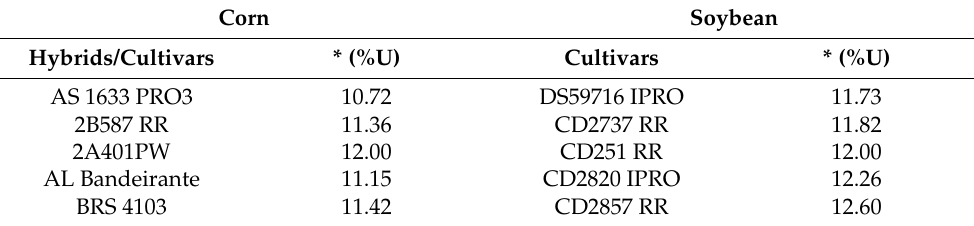
Table 1. Average water content for corn and soybean hybrids and/or cultivars. Corn Soybean Hybrids/Cultivars *